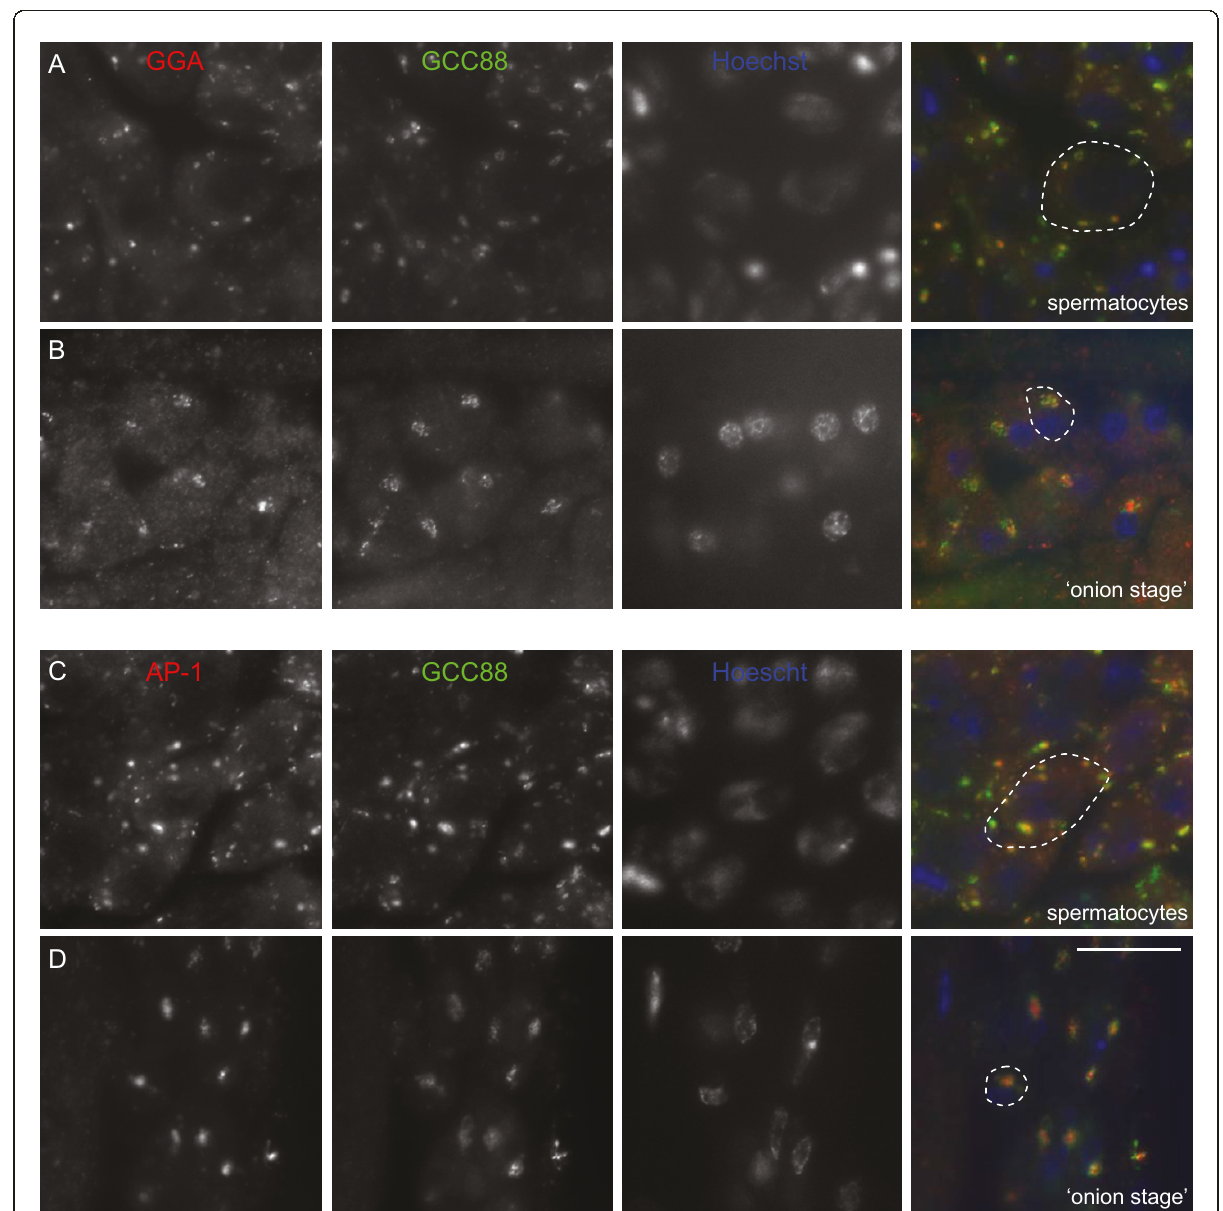
Figure 5 AP-1 and GGA co-localises with the TGN marker GCC88 in Drosophila testes . Testes squashes were triple labelled for either GGA or AP-1, the TGN marker GCC88 and Hoechst (nuclei). Note that GGA and AP-1 co-localises with GCC88 in spermatocytes (A,C) and at the acroblast in ‘ onion stage ’ spermatids (B, D) . Bar, 20 μ